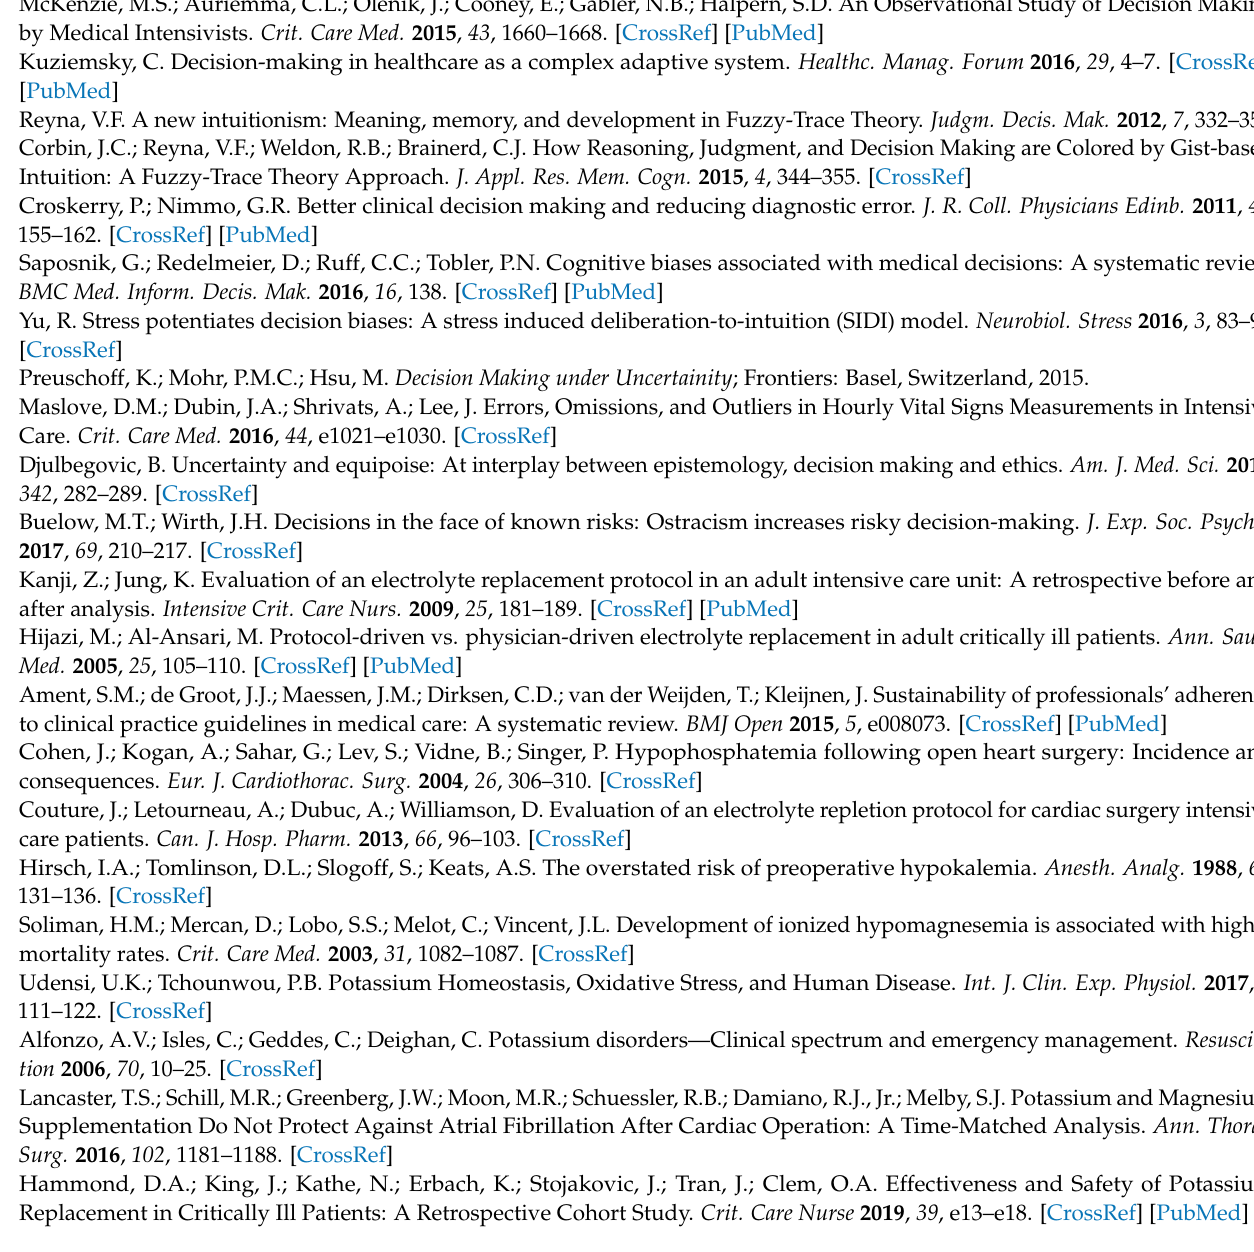
Figure A1. The workflow used for estimation of time and costs related to savings after the introduc- tion of RL to a clinical setting as a clinician-in-the-loop decision-making support tool.